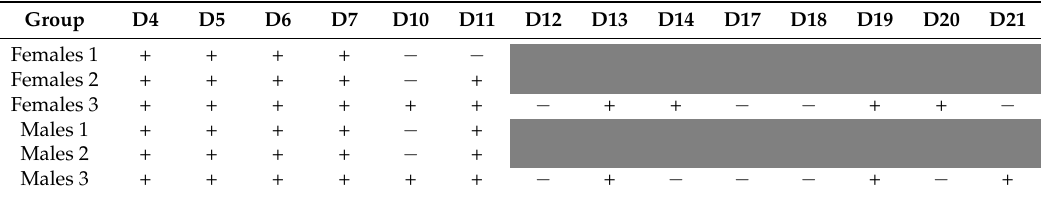
Table 1. Detection of MASV in sugar drops exposed to sand flies fed on MASV infected sugar meals at D0 and D2. Sugar drops were tested from D4 to D11 (groups 1 and 2), and D4 to D21 (group 3). +, MASV RNA positive; − , absence of MASV RNA.